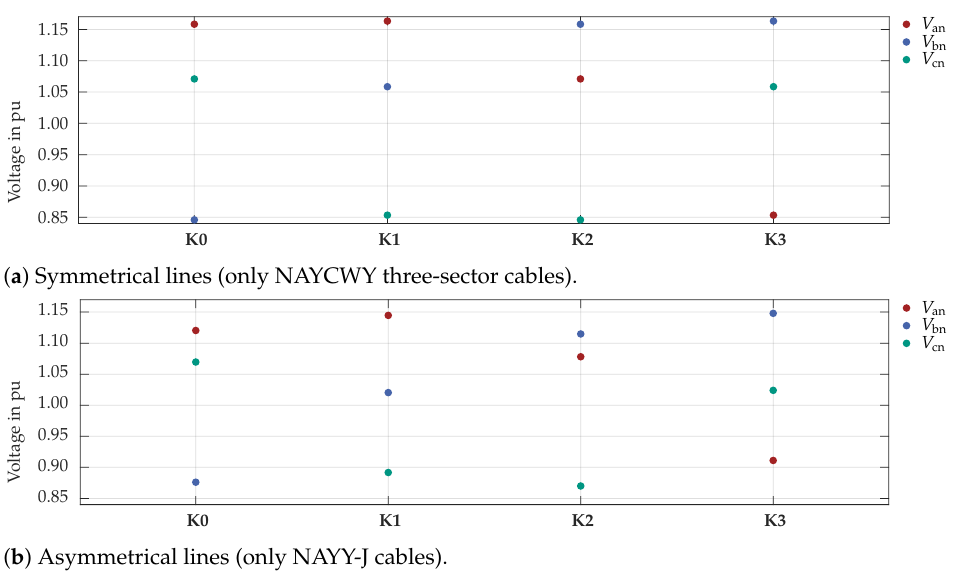
Figure 20. Voltages at node 19 for configurations